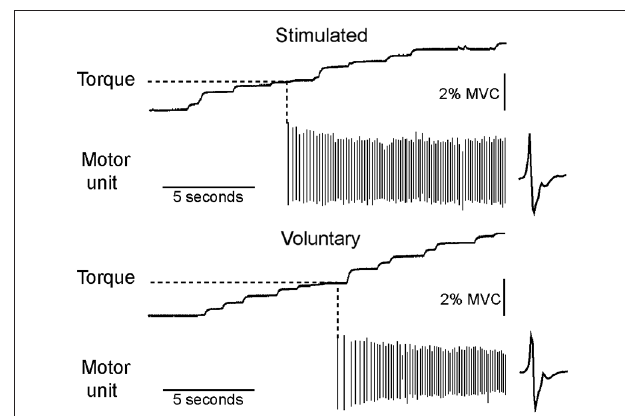
intramuscular motor unit EMG. (B) Delivering this low-current stimulation for 30 s at 60 Hz (as shown by the solid horizontal line) resulted in the gradual development of motor unit activity and ankle extensor torque.